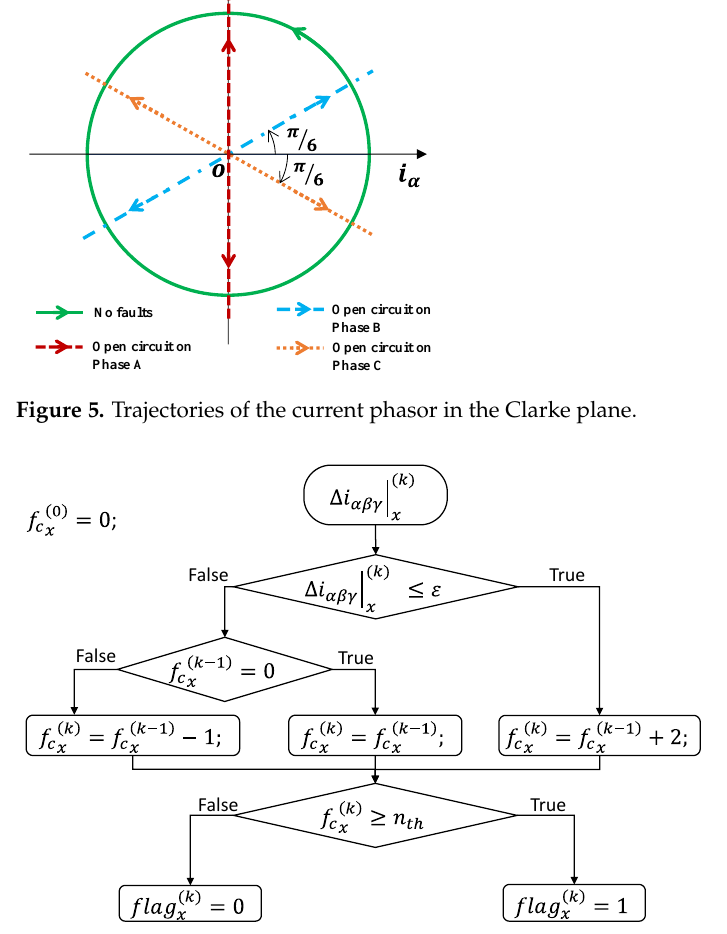
Figure 6. Flowchart of the FDI algorithms.